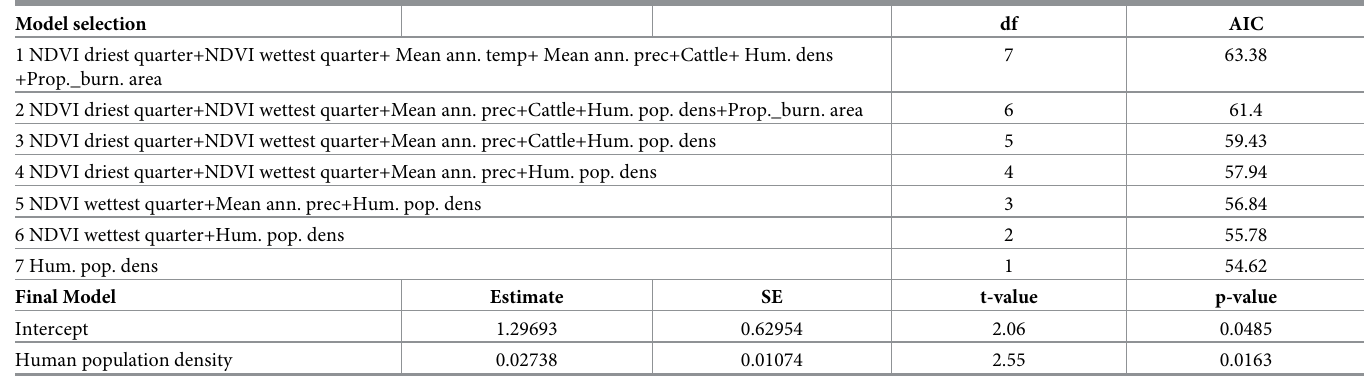
Table 3. General linear models used to evaluate the effect of predictors on the distribution of Hooded vultures and results of the final models. AIC values were used to select the best model in a forward stepwise method. Model